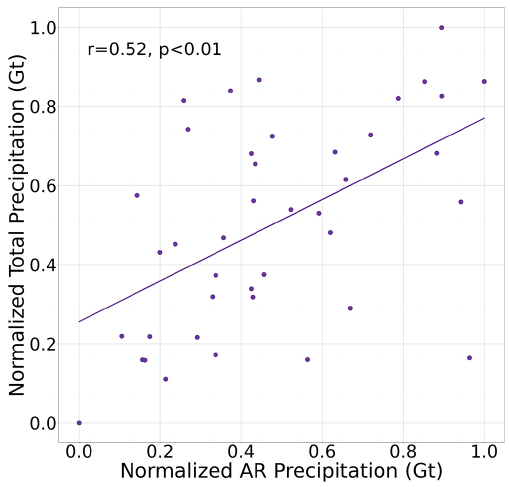
Figure A1. Correlation between normalized annual AR precipita- tion and the normalized annual total precipitation over the Amund- sen Sea Embayment and Marie Byrd Land. The Pearson correlation coefficient r = 0.52 ( p <